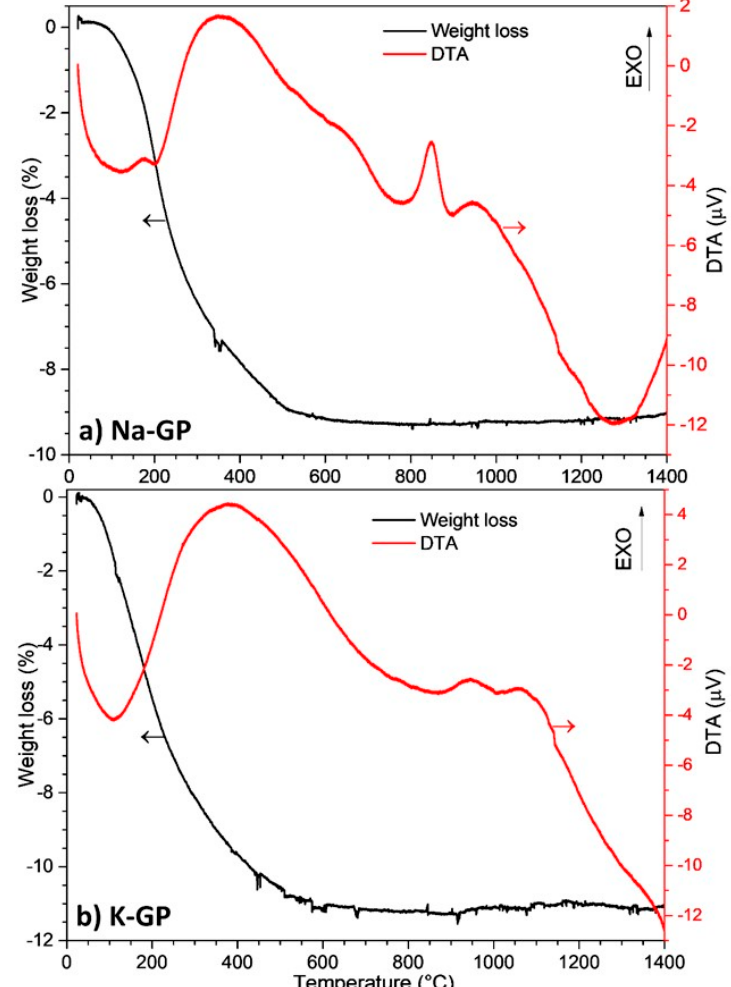
Figure 2. Thermal behavior of geopolymer samples: ( a ) Na-GP; ( b ) K-GP.